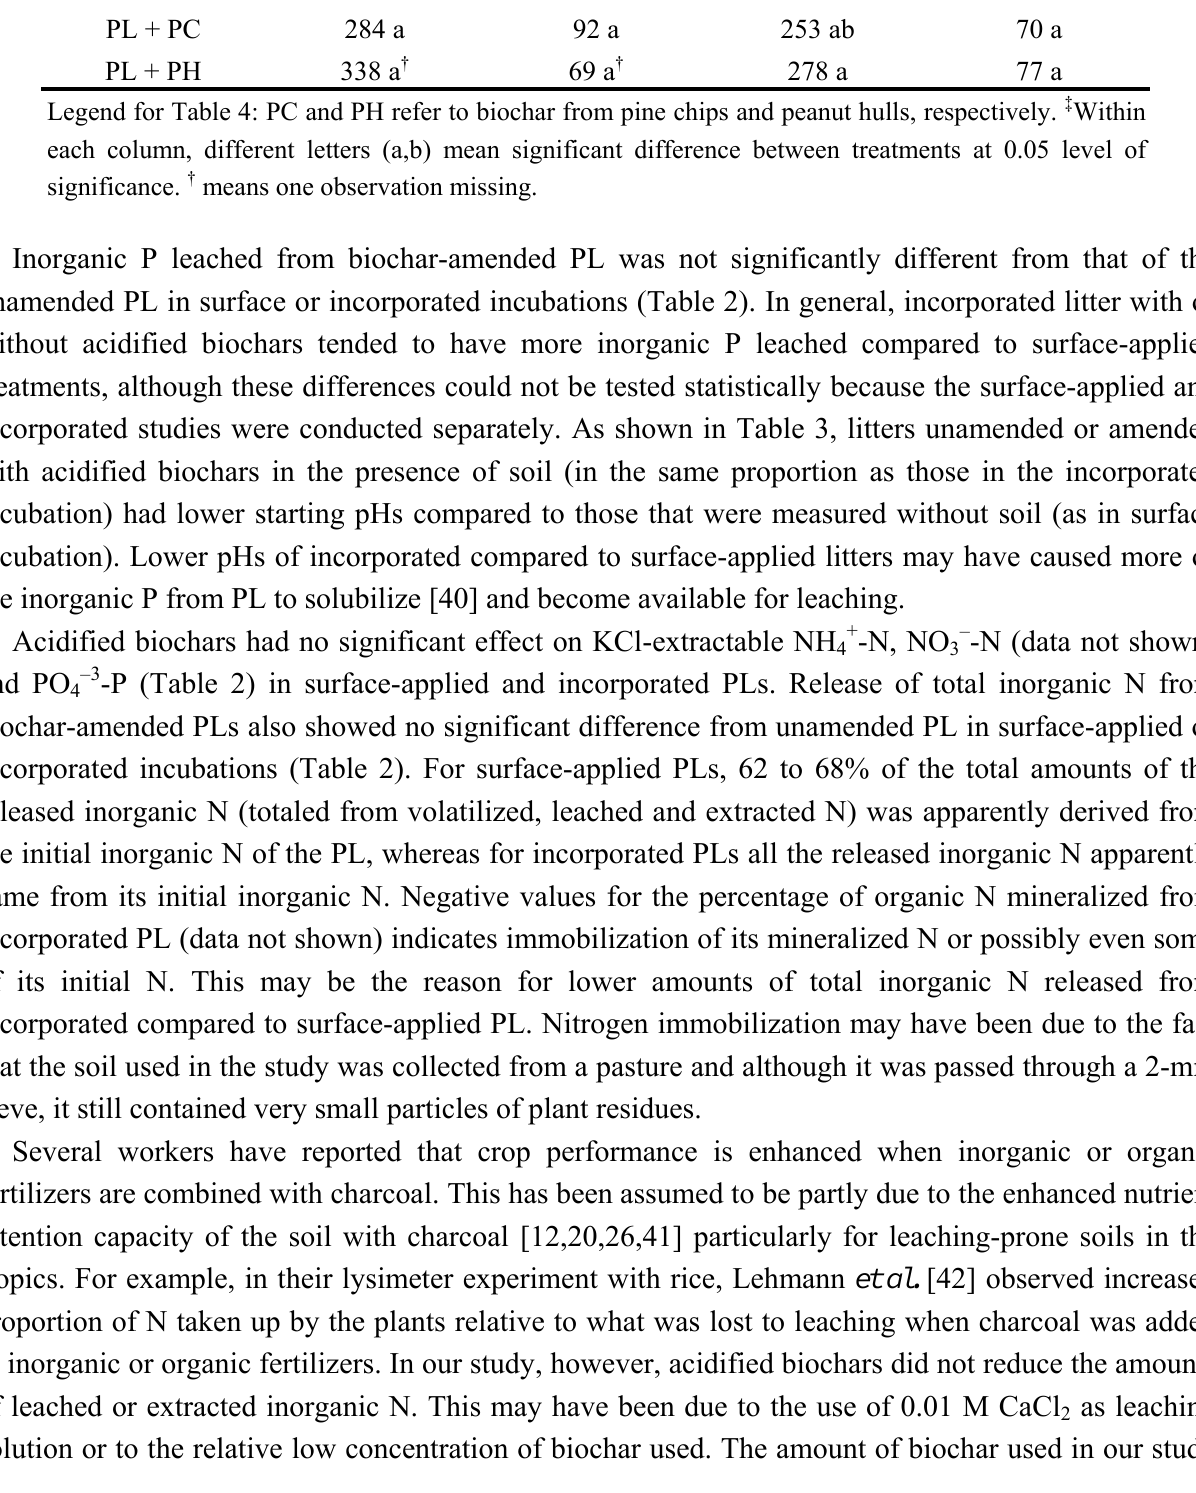
from soil (64.5 g, s) and poultry litter (PL, 2